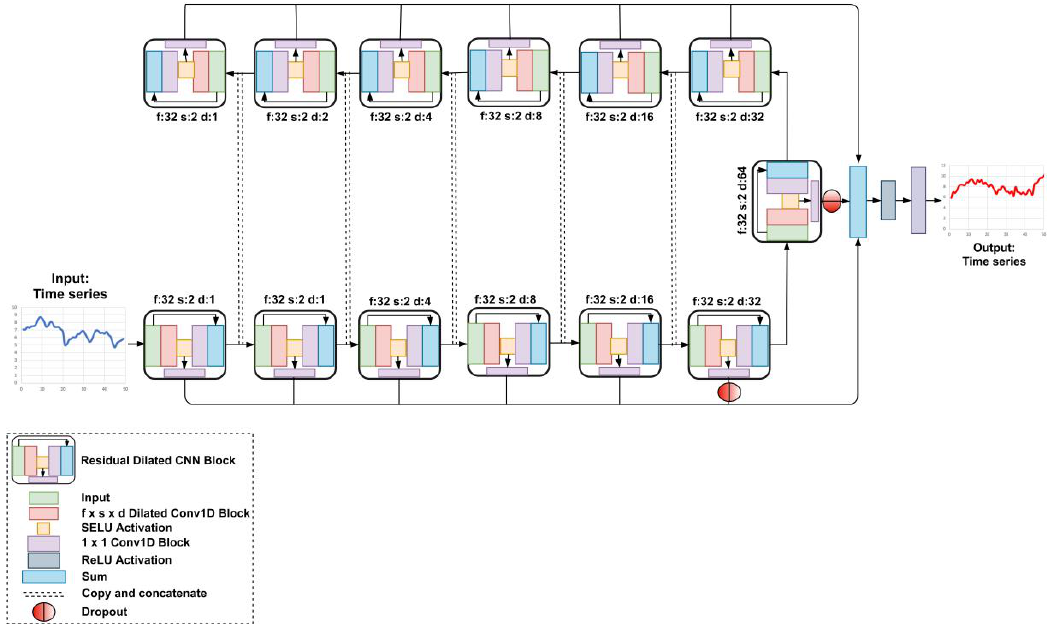
Figure 7. Residual U-Net (ResUnet) architecture for wind series time series